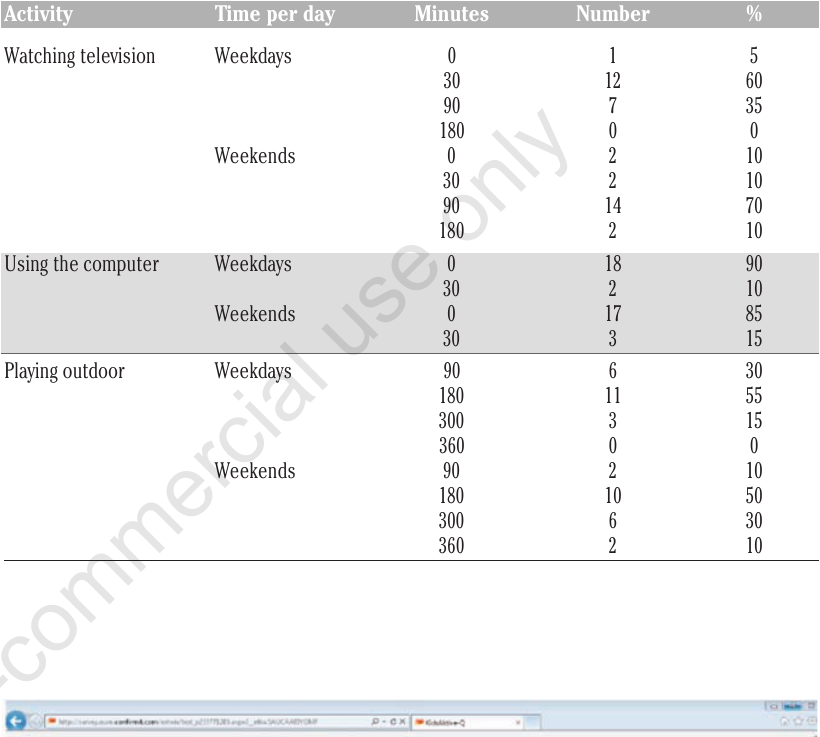
Table 2. Descriptive data based on responses to some questions in the KidActive-Q on the first occasion